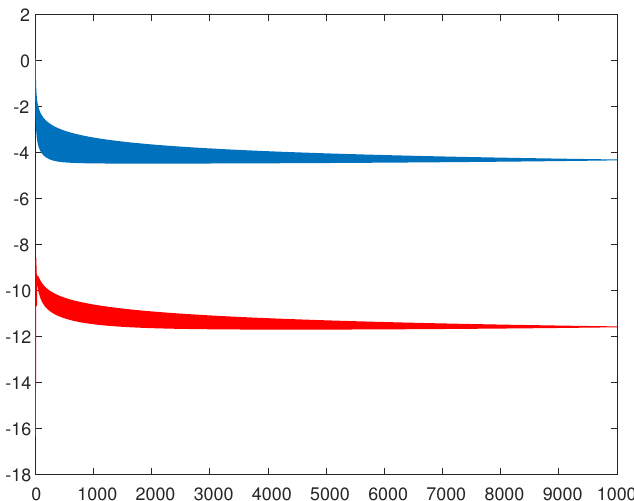
Figure 6. The approximation error for the 1D non-smooth case.